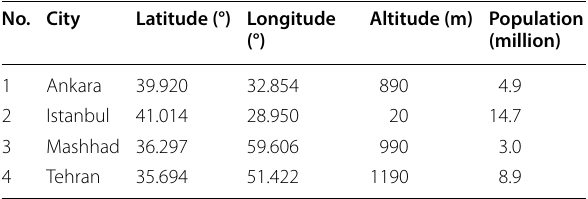
Table 1 Spatial and demographic profile of four